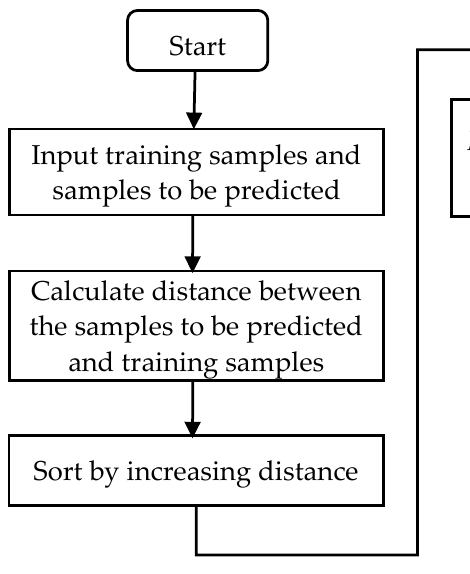
Figure 5. Structure of DNN.